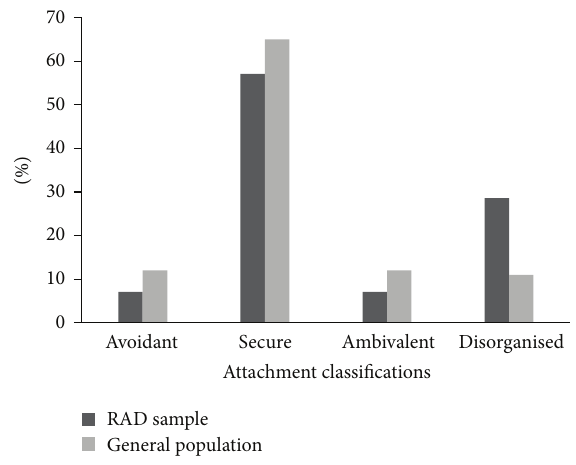
Figure 1: MCAST classifications in sample of RAD cases compared to the general population.